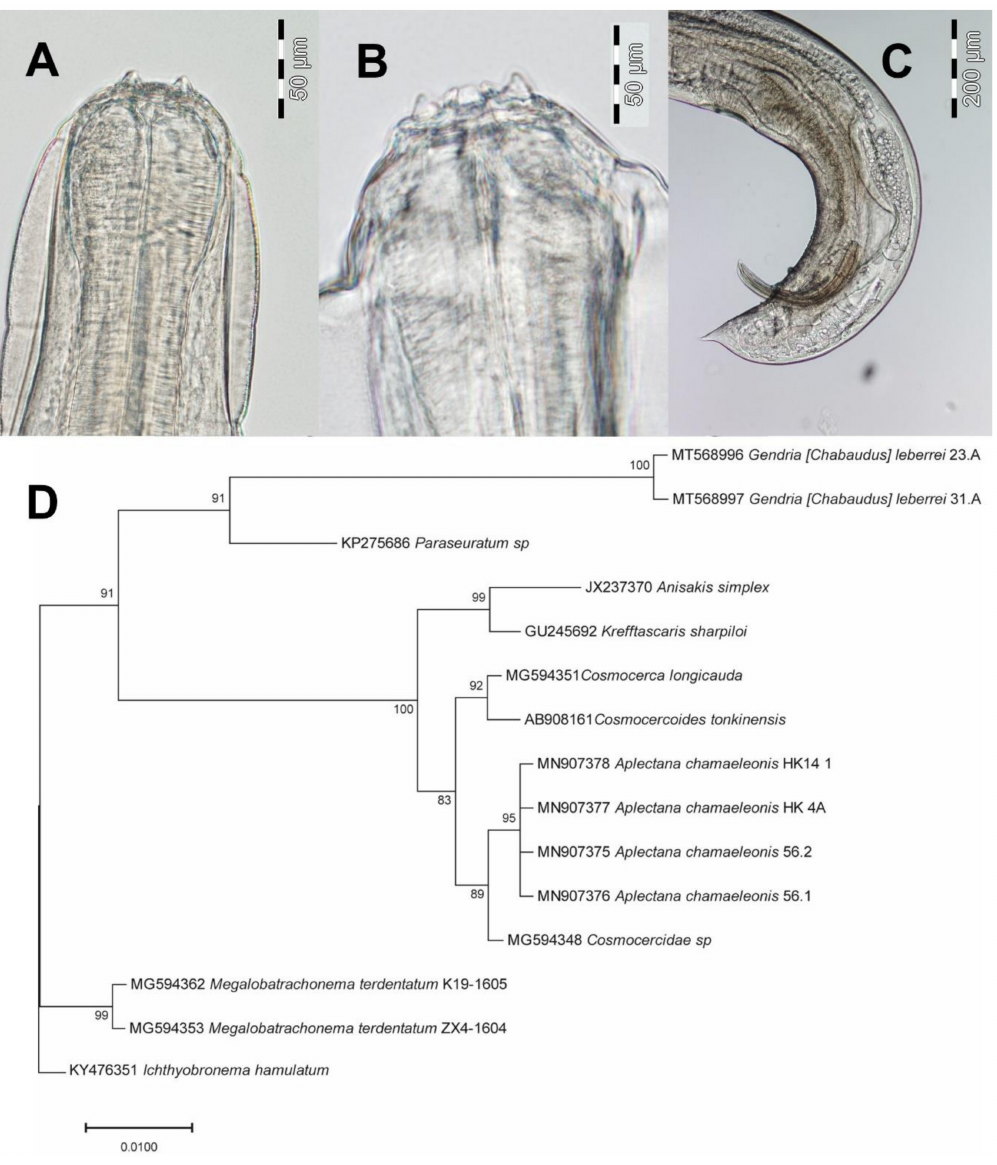
Figure 2. Gendria [Chabaudus] leberrei ( A – C ) and phylogenetic relationships ( D ). Lateral view on the anterior end of a live male ( A ). Apical protuberances of the labia ( B ). Tail region of a male with spicules ( C ). Scales are given in each photograph. ( D ) Bayesian tree of 18S rRNA sequences of G. leberrei and other species with similar sequences, rooted by Ichthyobronema hamulatum. Posterior probability values are indicated. Scale bar indicates substitutions per